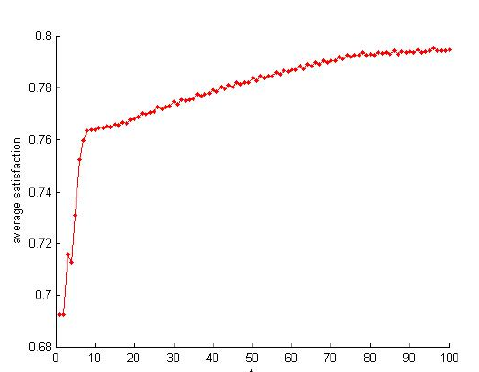
Figure 12. SOC in SN-1.